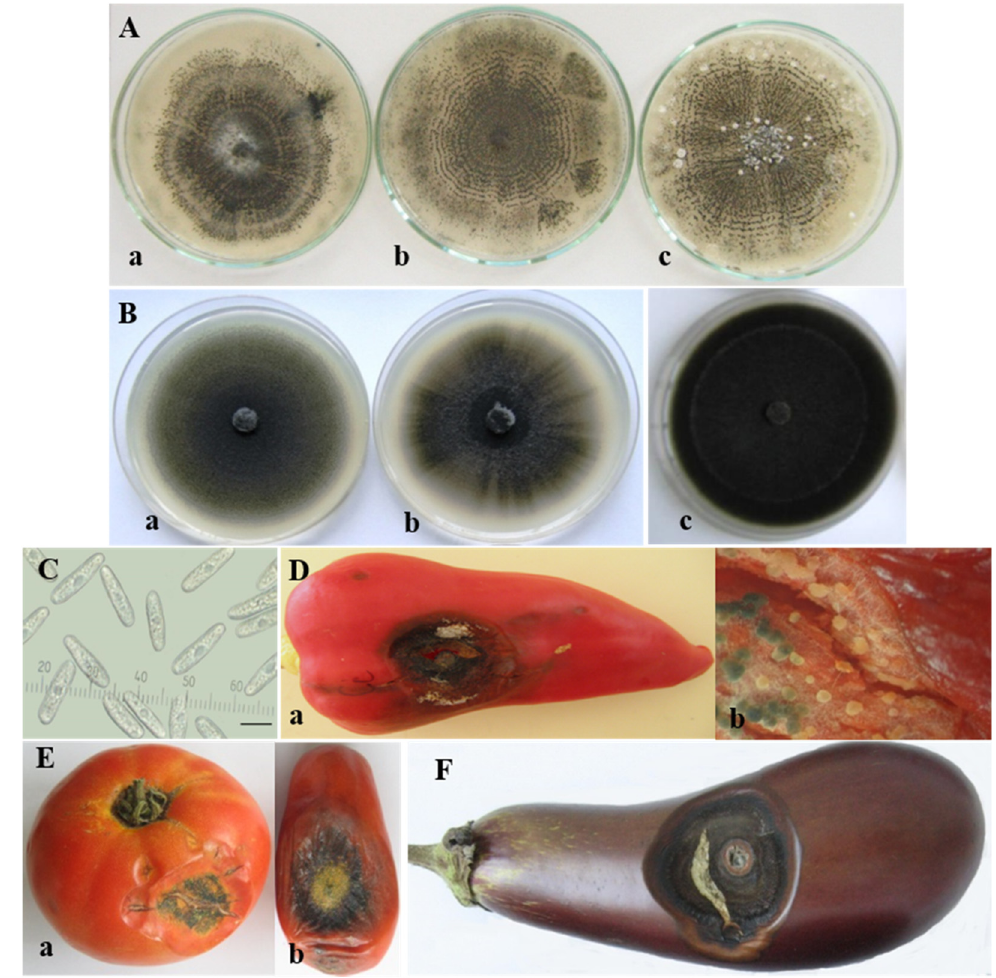
Figure 4. Colletotrichum coccodes group. Colony morphology of isolates obtained from: ( A ) fruits of: ( a ) pepper (B8-1); ( b ) tomato (Cc2-1-10); ( c ) eggplant (Cc40-1); ( B ) roots of pepper: ( a ) B12-9; ( b ) K-18 and tomato: ( c ) CBS 527.77; ( C ) conidia; scale bar = 10 µm; ( D – F ) advanced symptoms caused by C. coccodes (isolate B8-1) on artificially inoculated detached fruits of: ( D ) pepper—( a ) lesion with microsclerotia on the upper part of the fruit; ( b ) sporulating acervuli inside the fruit beneath the lesion (×16); ( E ) tomato—( a ) salad variety; ( b ) processing variety; ( F ) eggplant.